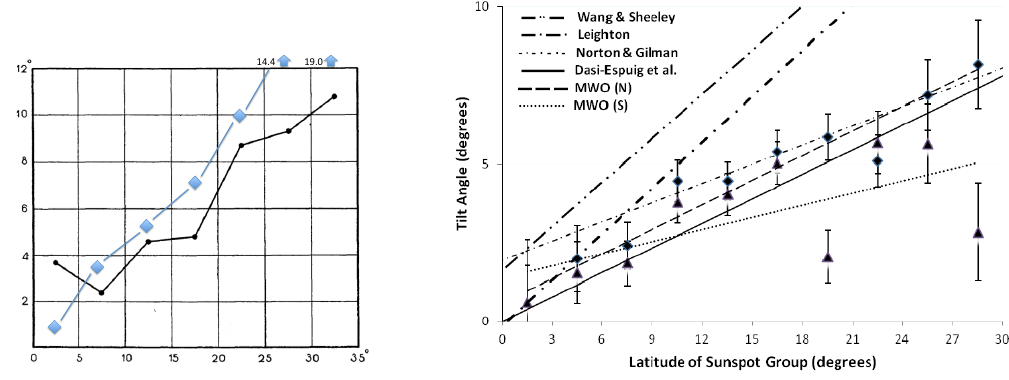
Figure 7: Left: The base plot (black dots) shows the first statistical study of the latitude-dependence of the tilt angle of the axis of bipolar sunspot groups carried out by Joy on sunspot drawings of Carrington (1856 – 1861) and Sp¨orer (1861 – 1893), as published in Hale et al. (1919). The y-axis shows the mean tilt angle and the x-axis the latitude. The study was carried out on 2633 sunspot groups over 3.5 solar cycles. Over-plotted are the results by Brunner (1930) (blue diamonds), obtained from a comparably large dataset of 8774 measurements of 1981 sunspot groups observed over three cycles (1894 – 1928) in Z¨urich. Thus, this combined plot of axial tilt angles is based on sunspot group observations of 6.5 continuous cycles. Right: Axial tilt angle of sunspot groups based on the Mt. Wilson white-light data between 1917 – 1985. Image reproduced with permission from McClintock and Norton (2013); copyright by Springer. Northern (diamond) and southern (triangle) hemispheres. Data were binned in 3 (cid:176) latitude. Error bars represent the standard error of the mean. For comparison, Joy’s law equations by Wang and Sheeley Jr (1991), dashed-dot-dot; Leighton (1969), large dash-dot; Norton and Gilman (2005), small dash-dot; Dasi-Espuig et al. (2010), solid. Linear fit for N and S hemisphere data (dash and dot, respectively) is also shown. Wang and Sheeley Jr (1989, 1991), analysing 2700 bipolar ARs (they call them BMRs) identified in Kitt Peak magnetogram data between 1976 – 1986 (cycle 21), found that for lower-flux